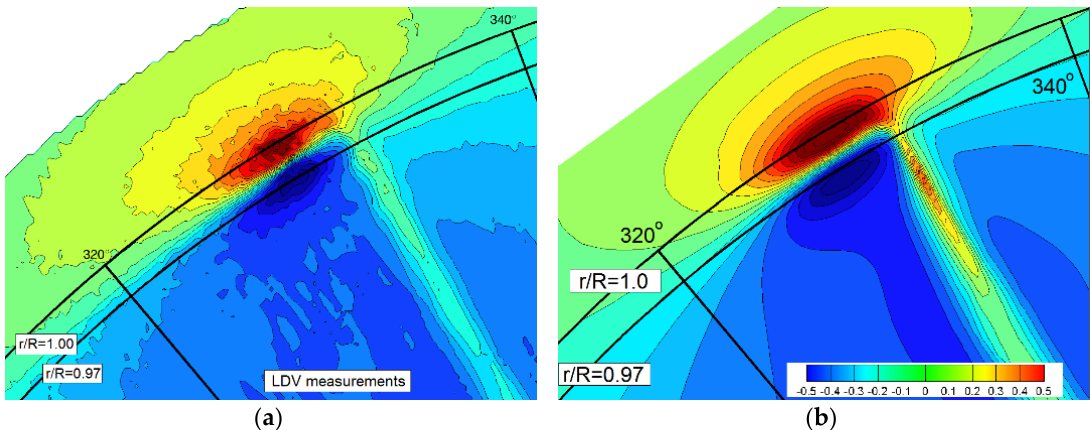
Figure 13. Comparisons between the wake components measured [44] and computed at x / D =0.2. ( a ): r / R =0.7; ( b ): r / R =0.9; ( c ): r / R =0.97; ( d ): r / R =1.0.